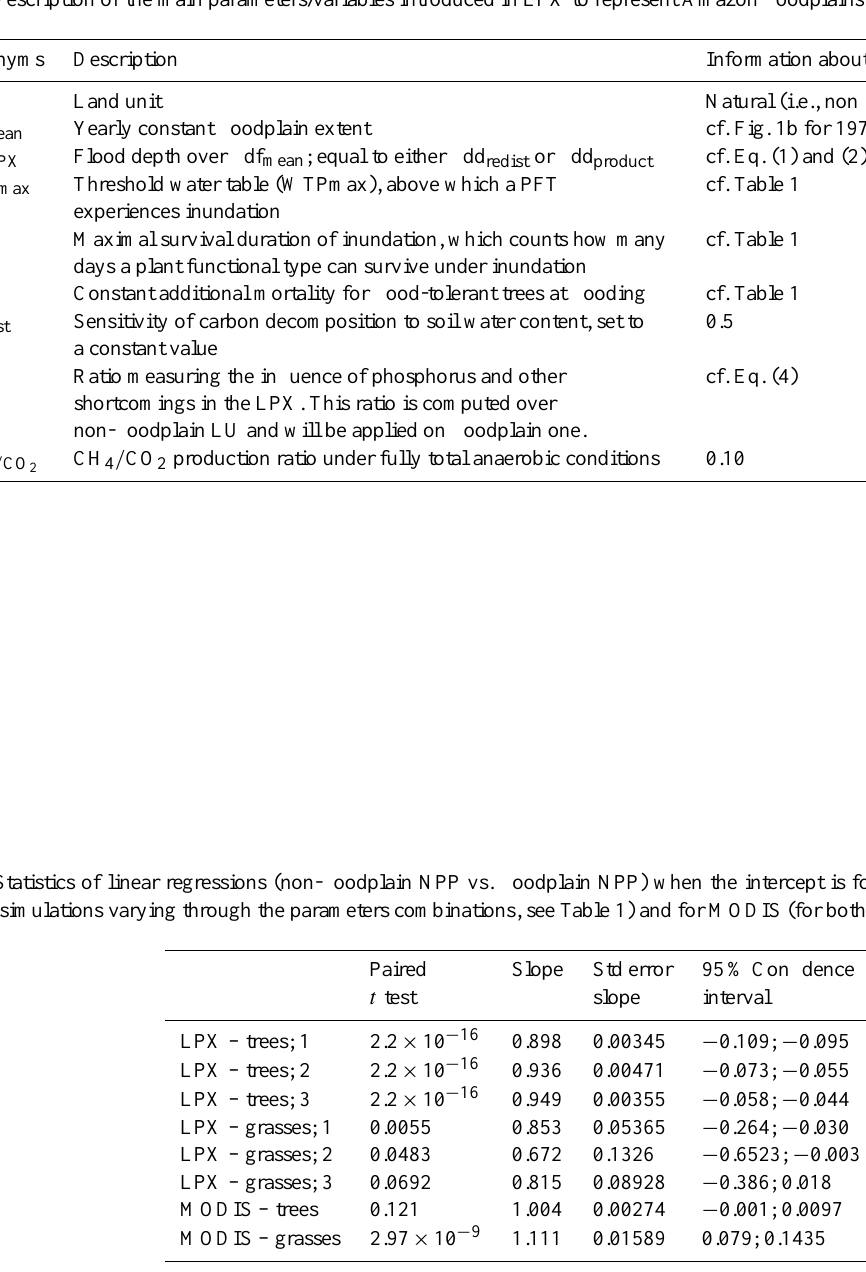
Table A1. Description of the main parameters/variables introduced in LPX to represent Amazon floodplains.